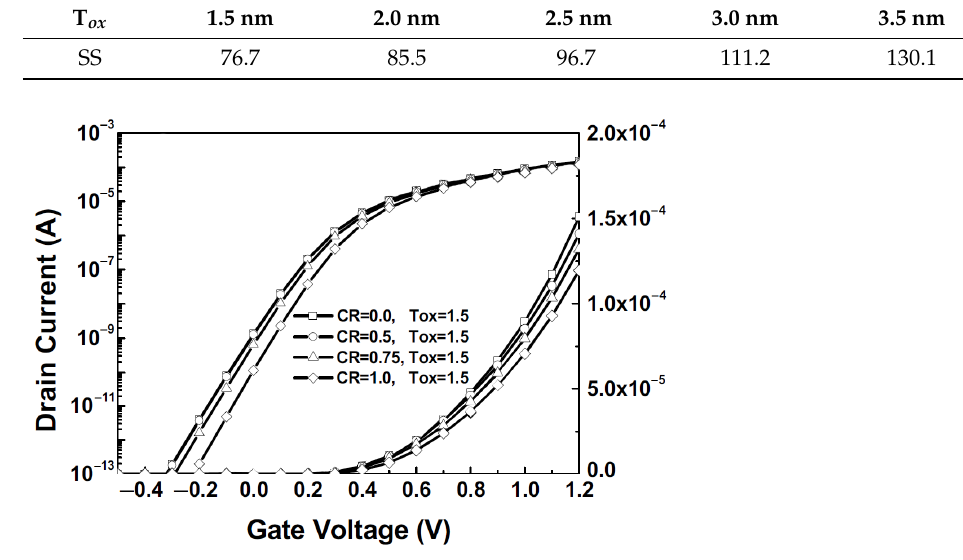
Figure 10. I d -V g characteristics with respect to corner rounding and T ox ; CR is corner rounding ratio 2R/W nw , where R rounding